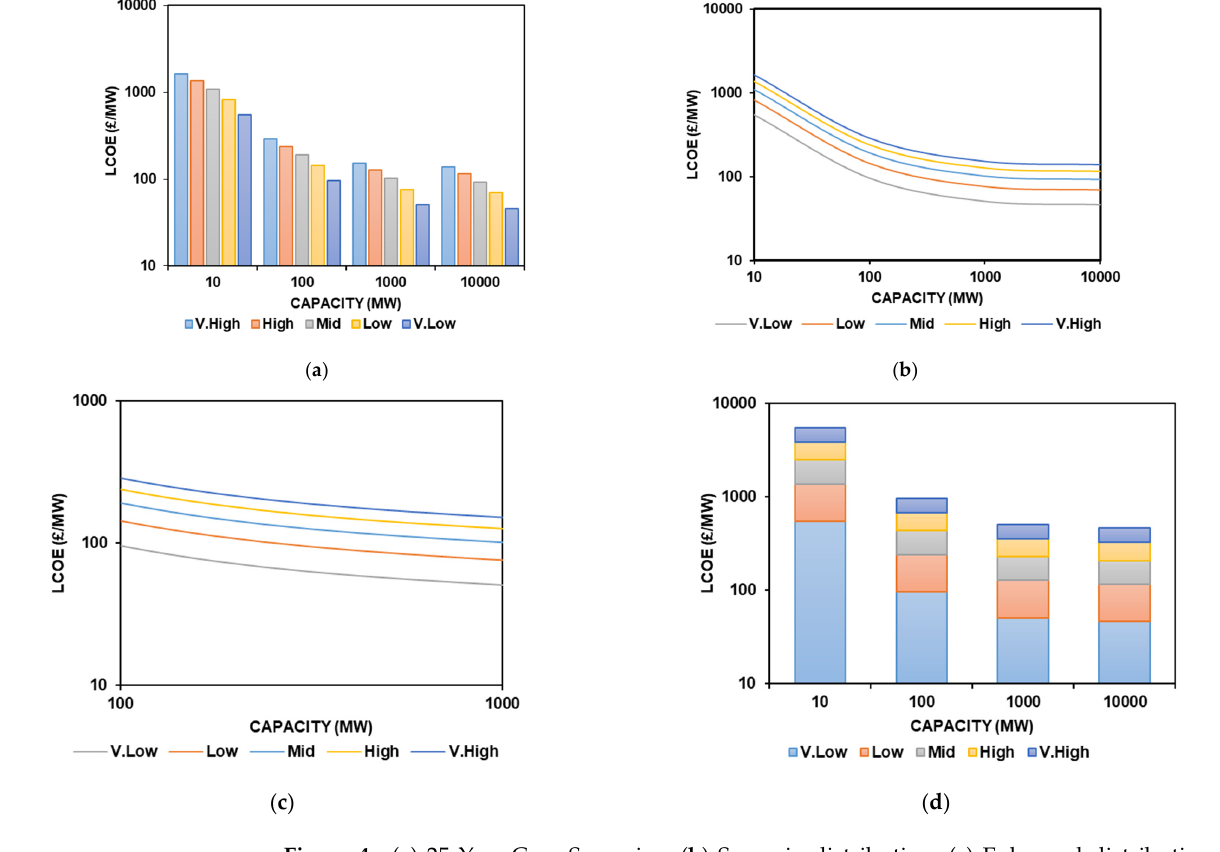
Table 9. LCOE Increase per Year.